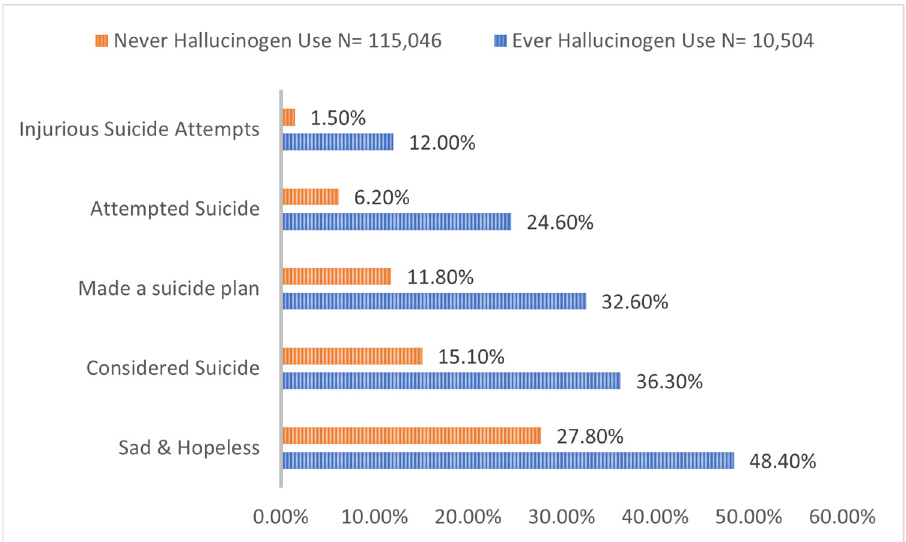
Figure 2. Prevalence of hopelessness and suicidality in adolescent hallucinogen users.